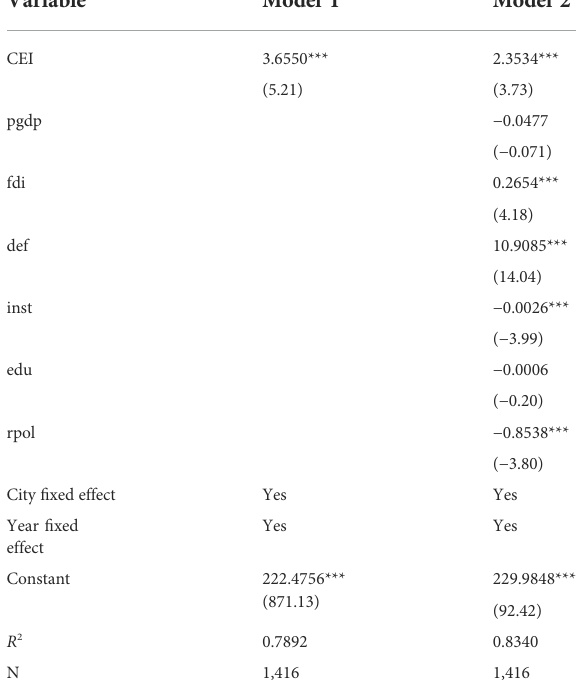
TABLE 3 Results of empirical